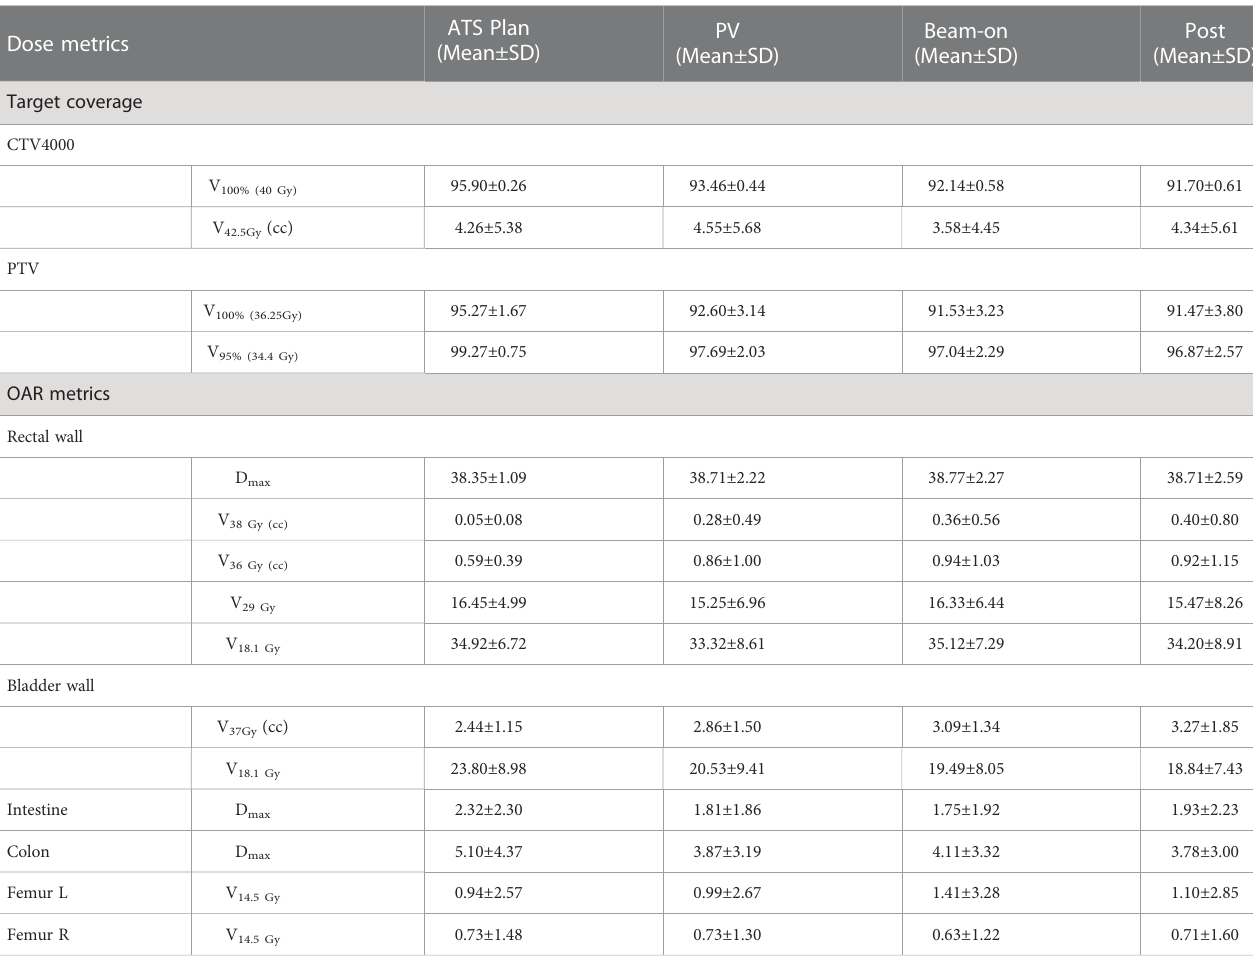
TABLE 1 Dose metrics for the original ATS plan and re-computed plans on PV-MR, beam-on MR and post-MR